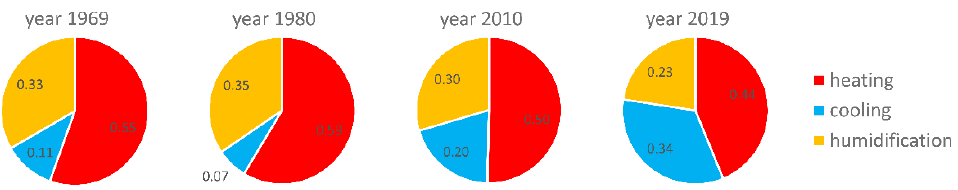
Figure 13. Share of energy for air treatment steps in total energy demand, t sup 3 = 18 °C.